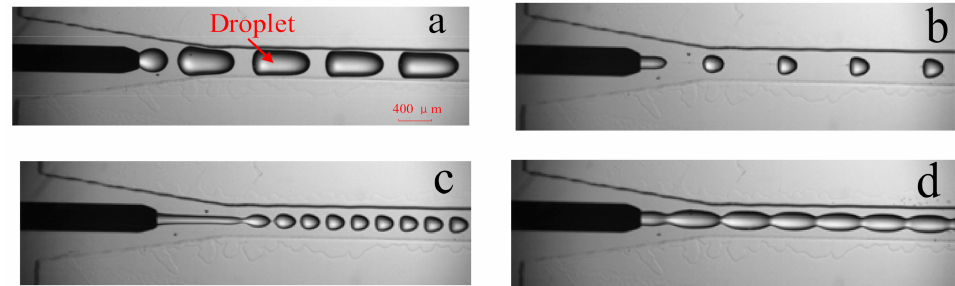
Figure 2. Four flow patterns in both Experiment 1 (gas-liquid) and Experiment 2 (liquid-liquid). ( a ) Slug, ( b ) dripping, ( c ) jetting, ( d )